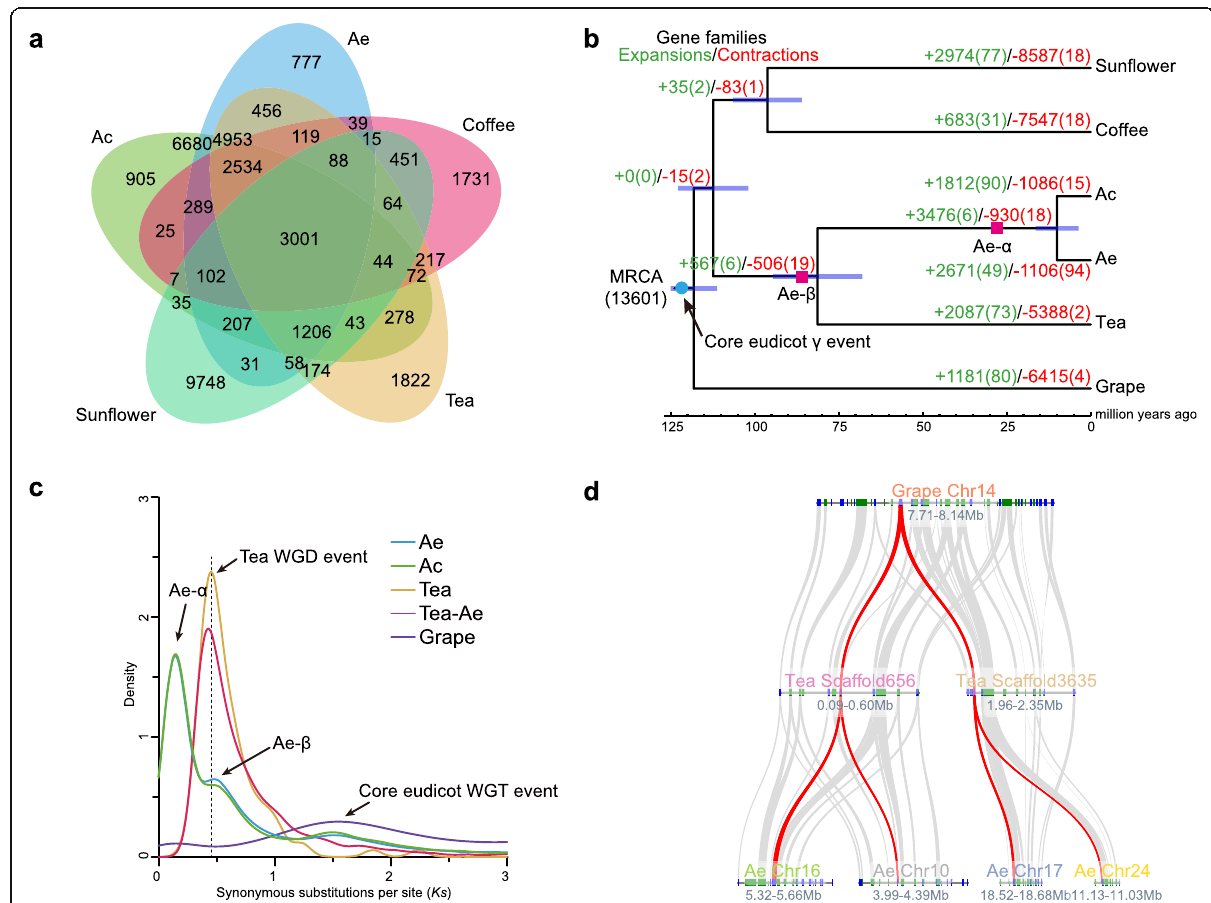
Fig. 2 Evolution and comparative genomic analysis of Actinidia eriantha (Ae). a Number of gene families shared between Ae, A. chinensis (Ac) and three other asterid plants. b Phylogenomic analysis of Ae and other representative asterid plants. The potential whole genome duplication (WGD) events and expansion and contraction of gene families among these species are shown on the tree. The divergence time was estimated for each node. c Distribution of synonymous substitution rates ( Ks ) for pairs of syntenic paralogs in Ae and three other genomes. d A typical collinearity pattern between grape, tea and Ae genomes. Rectangles represent predicted gene models with color showing relative orientations (blue, same strand; green, opposite strand). Gray wedges connect matching gene pairs with one highlighted in